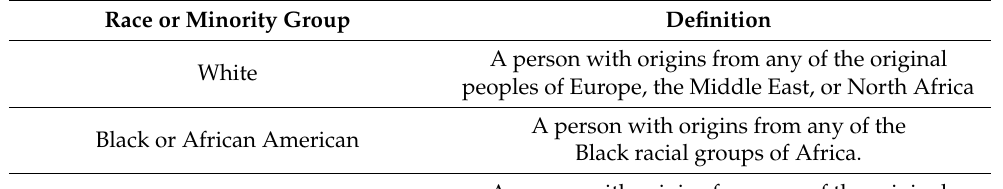
Table 2. Definitions for racial or minority groups from the U.S. Census Bureau